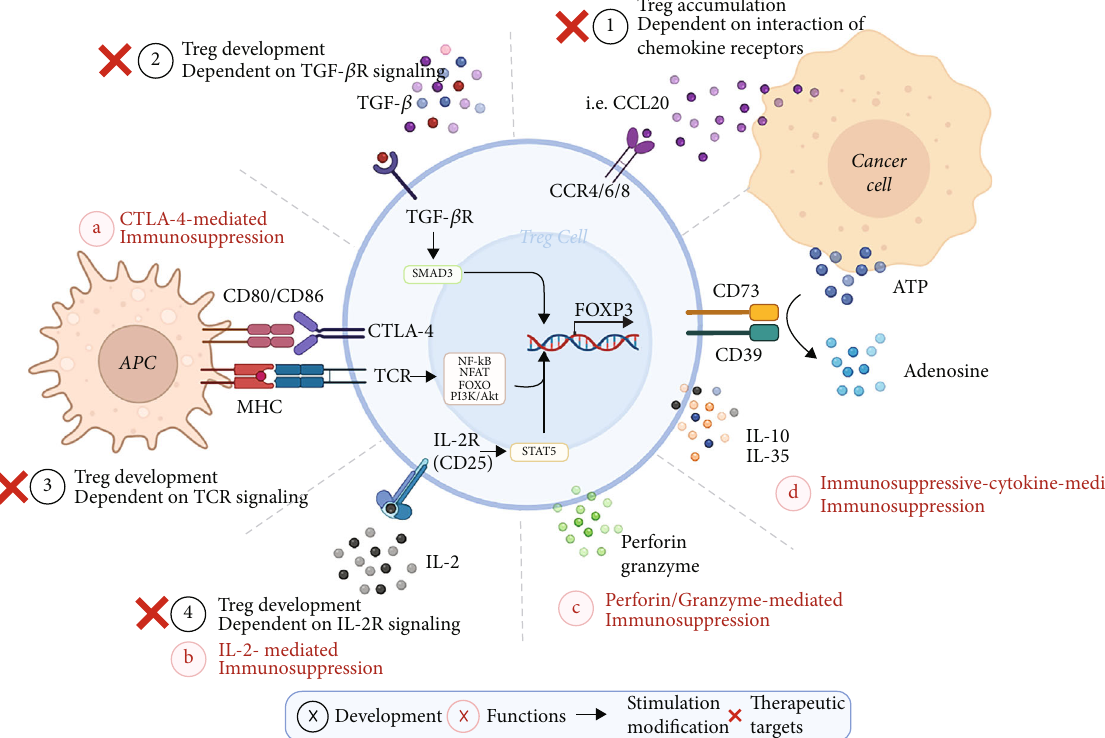
Figure 1: Prime mechanisms of Treg-mediated immunosuppression and associated therapeutic targets in NSCLC. Black: in the tumor microenvironment (TME), the development of regulatory T cells (Tregs) depends on several main factors that contribute to the FOXP3 expression: (1) the interaction of chemokine receptors, (2) TGF- β R signaling between Treg and cancer cells, (3) TCR, and (4) IL-2R signaling in Tregs. Red: Tregs express the high-a ffi nity IL-2 receptor binding to and sequestering IL-2 to reduce its availability to e ff ector T cells. They also express cytotoxic T lymphocyte antigen 4 (CTLA-4), which binds to CD80 and CD86, with a higher a ffi nity than CD28, on antigen-presenting cells (APCs), thereby transmitting suppressive signals to these cells. In addition, Tregs can produce immunosuppressive cytokines, granzymes, and perforin to inhibit immunity. Red cross: di ff erent therapeutic approaches have been explored in downregulating Treg cell expansion mediated by chemokine or TGF- β in the TME. In addition, inhibitors targeting TCR and IL-2R signaling have been tested in reducing Treg cell activation and proliferation in